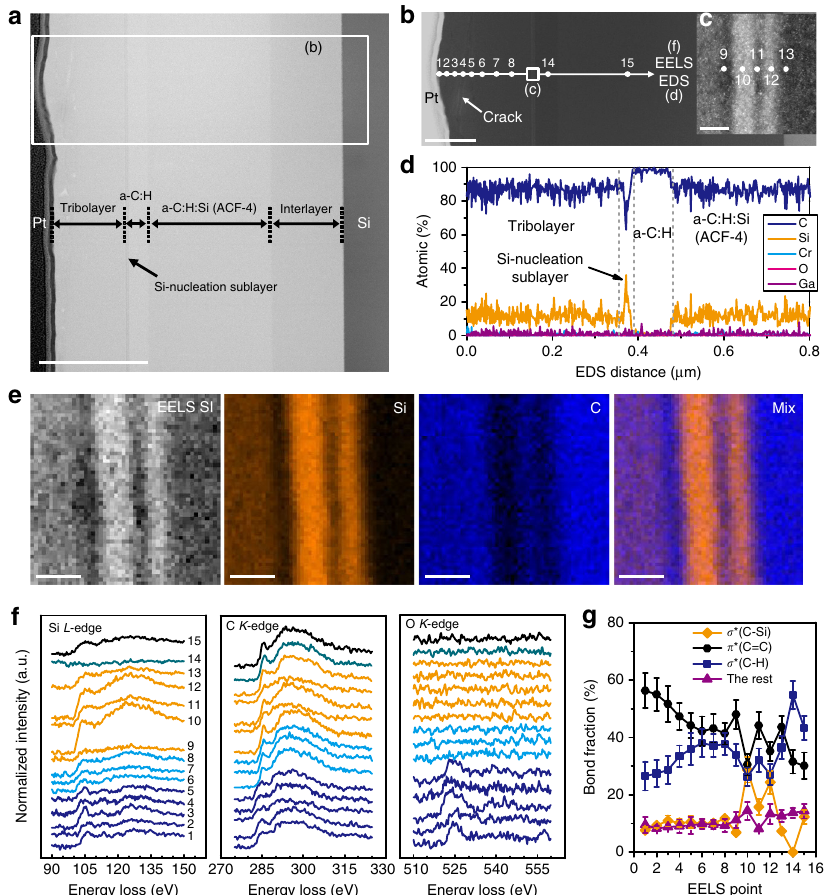
Fig. 6 Characterization of the contact area produced on a-C:H:Si fi lm-coated Si wafer surface. The corresponding friction test for self-mated a-C:H:Si (5.7 at % Si, ACF-4) surfaces is shown in Supplementary Fig. 10. The tribo-induced transfer of partial fi lm material from the ball surface to the wafer side and the Si-triggered growth of an incomplete tribolayer in the wafer wear track were observed. Note that, to distinguish the growth interface of the tribolayer on the wafer side, a pure a-C:H layer was deposited on top of the a-C:H:Si (ACF-4) layer. a BF-STEM image showing the cross-sectional morphology of the tribolayer-covered wafer wear track. The growth of this tribolayer was triggered following the formation of a Si-nucleation sublayer along the sliding interface. Scale bar, 0.5 μ m. b HAADF-STEM image across the wafer wear track as marked in a . Scale bar, 0.2 μ m. c HAADF-STEM image showing the Si- nucleation sublayer. Scale bar, 10 nm. d EDS-elemental distribution across the wafer wear track as marked in b . e EELS-SI mapping image of the Si- nucleation layer and the corresponding extracted Si- L , C- K and mix maps. Scale bars, 10 nm. f Evolution of Si- L , C- K and O- K EELS spectra recorded across the cross-sectional wear track as marked in b and c . g Evolution of the calculated C-bonds fractions from the C- K edges presented in f . Error bars denote